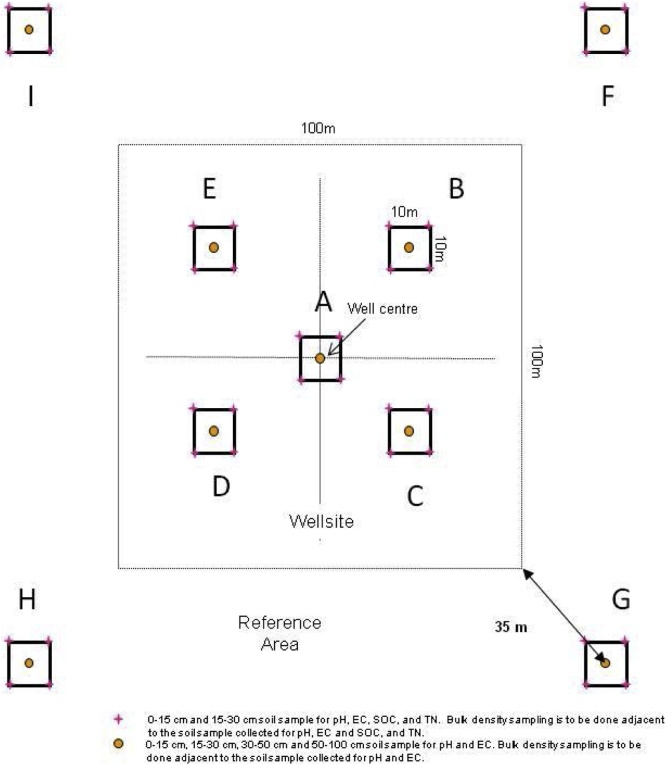
Soil parameters are sampled within the 10 × 10 m plots identified in the diagram.